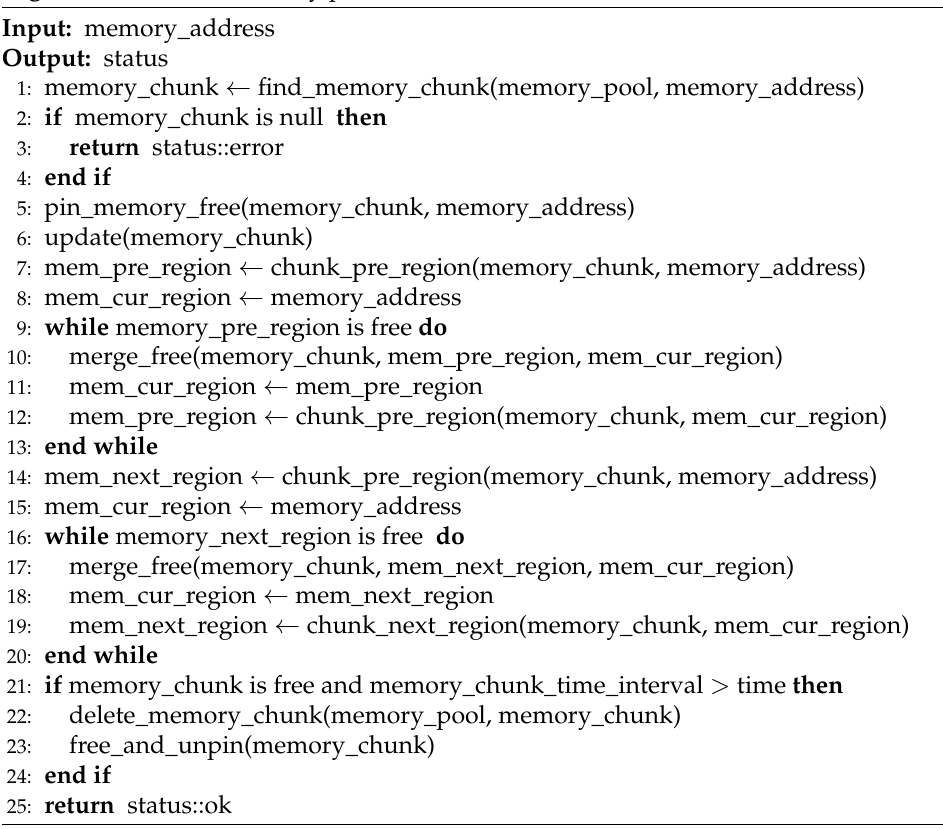
Algorithm 2 Pinned memory pool